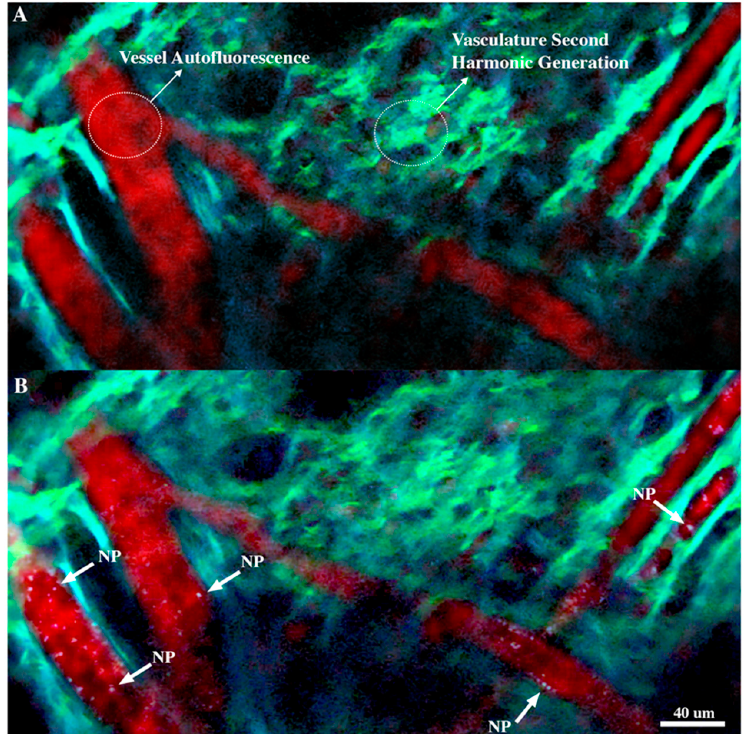
Figure 3. Label-free wide field views from video acquisition of gold–silica nanoparticle flow in ear vasculature. ( A ) Vascular network image prior to gold–silica nanoparticle injection. Background vessel autofluorescence is seen in red, while tissue autofluorescence and SHG (second harmonic generation) are observed in cyan. Red blood cell shadows can be observed as dark spots within the vessels. Imaging channels are a composite of three channels from 450 to 600 nm. ( B ) Vascular network image following gold–silica nanoparticle intravenous injection. Gold–silica nanoparticles appear as